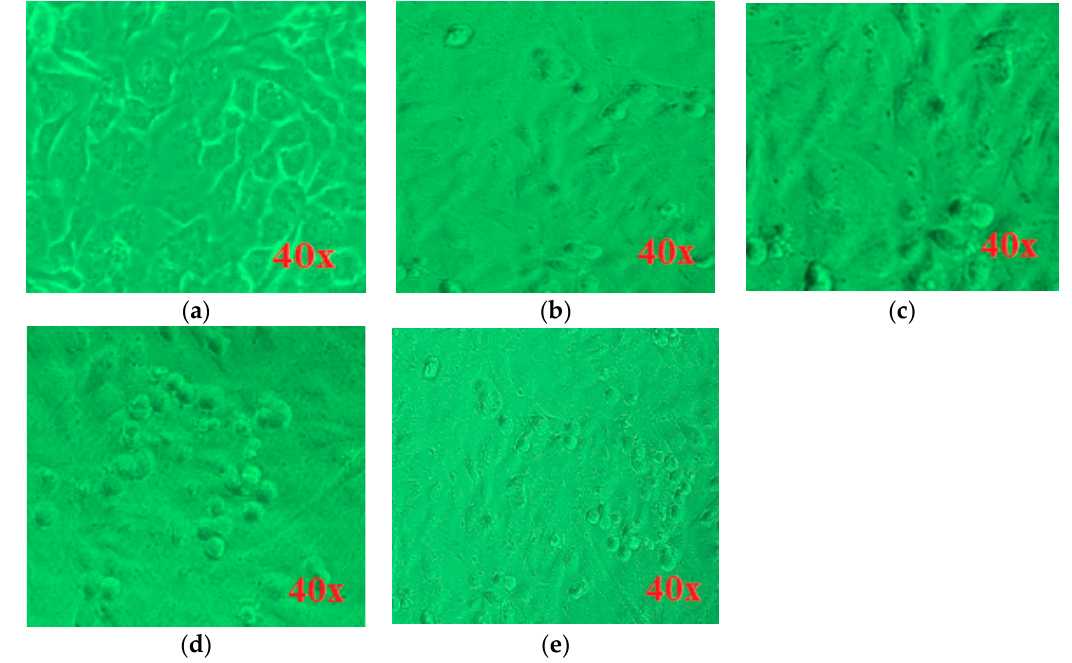
Figure 8. GO-ZnO induced morphological variations in MCF-7 cells at magnification 40× ( a ) control;